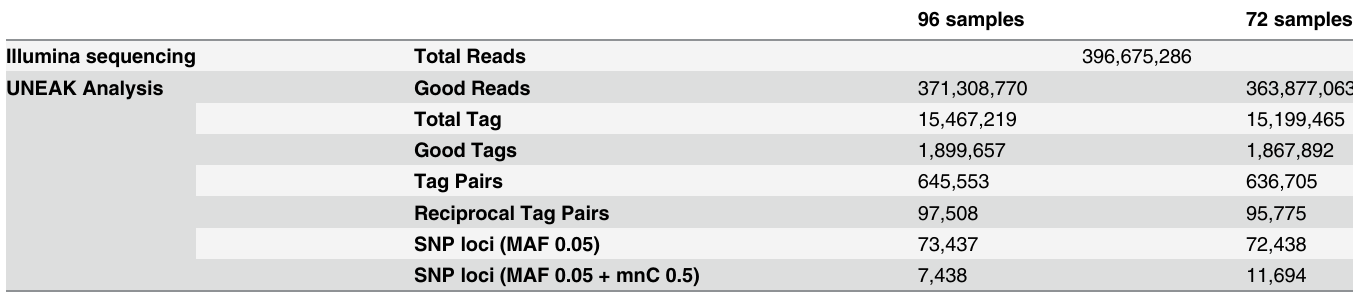
Table 2. Summary of GBS analysis of alfalfa samples with UNEAK in the complete 96 samples dataset and the subset of 72 samples with > 1million reads.